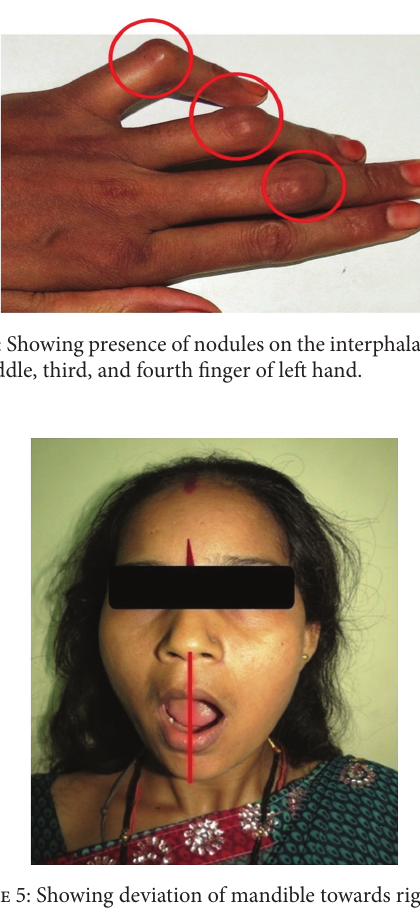
Figure 1: Showing minor joint deformity with stiffness of the interphalangeal joints of the hand.